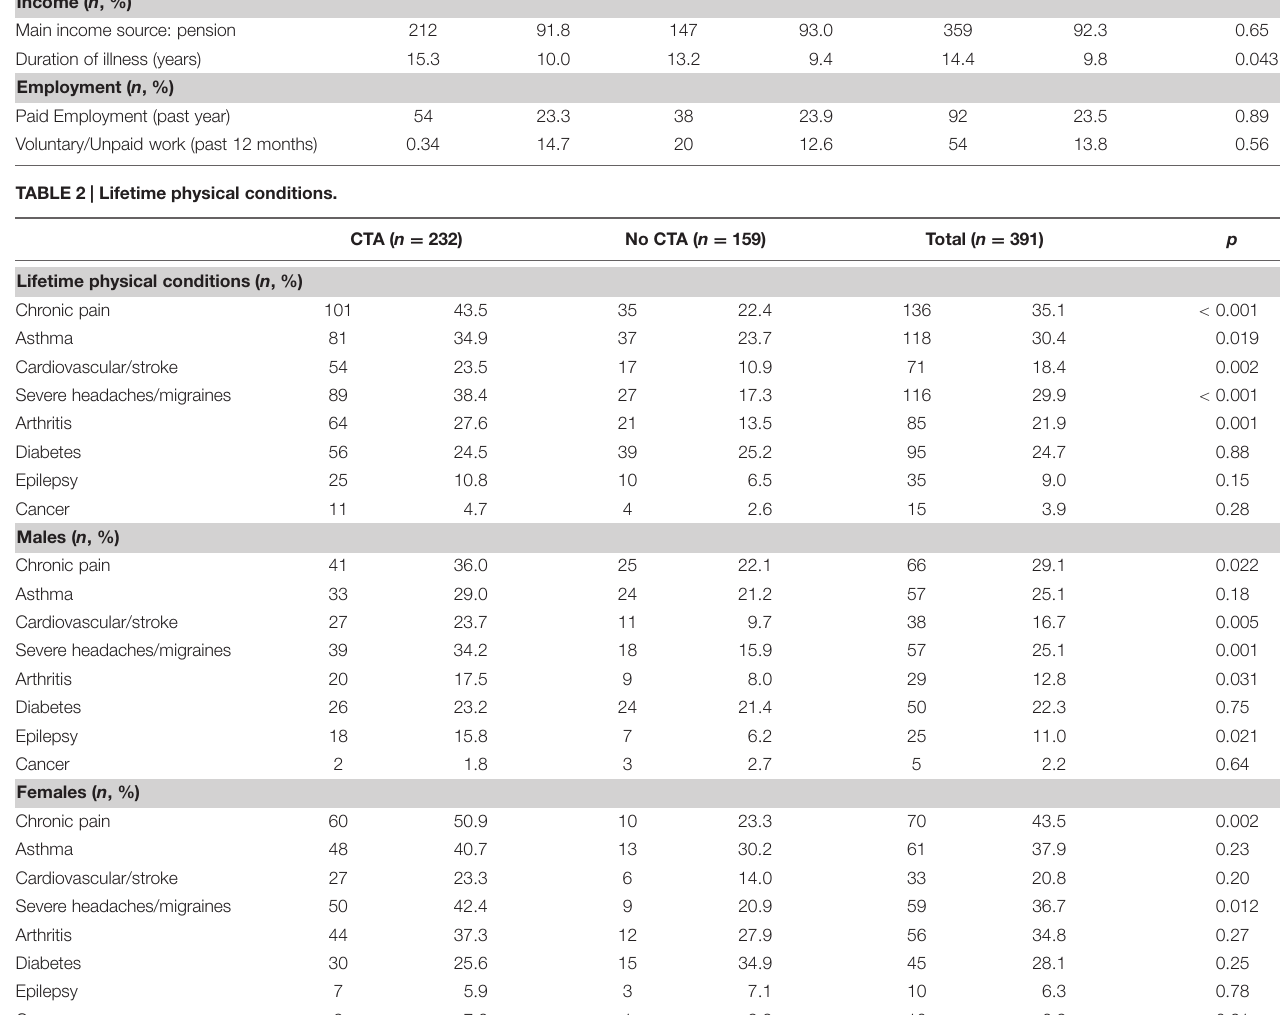
TABLE 2 | Lifetime physical